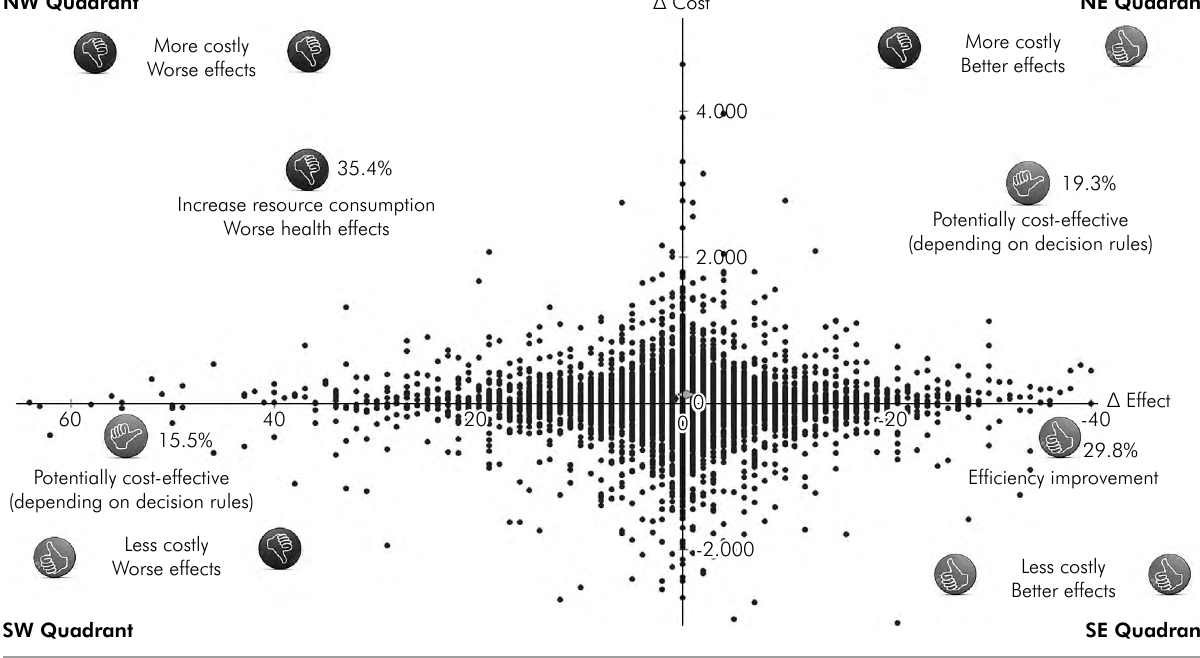
Figure 5. Cost-effectiveness plane – simulated points to explore uncertainties around the central values of incremental costs (delta cost) and effects (delta effect). Percentage values in the quadrant represent the probability of the new intervention is in that determined area of the plane (Quadrants: NE-North-East; NW: North-West; SE: South-East; SW: South-West).